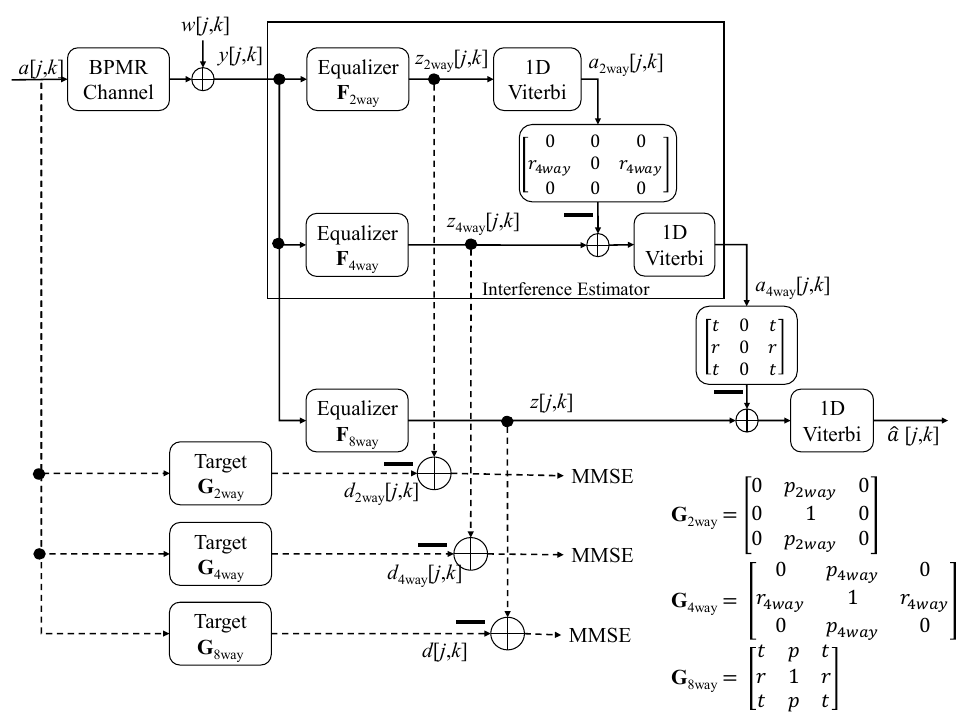
Figure 6. Proposed detection scheme using the multilayered 2D GPR